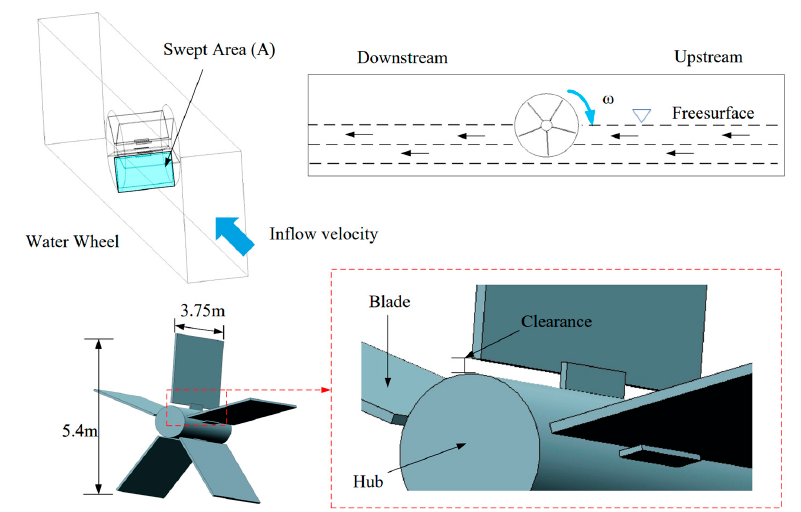
Figure 1. Geometric model and operating condition of the water wheel.